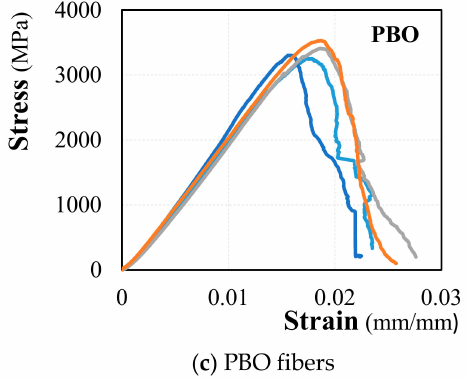
Figure 4. Tensile tests of dry textile: stress-strain curves.